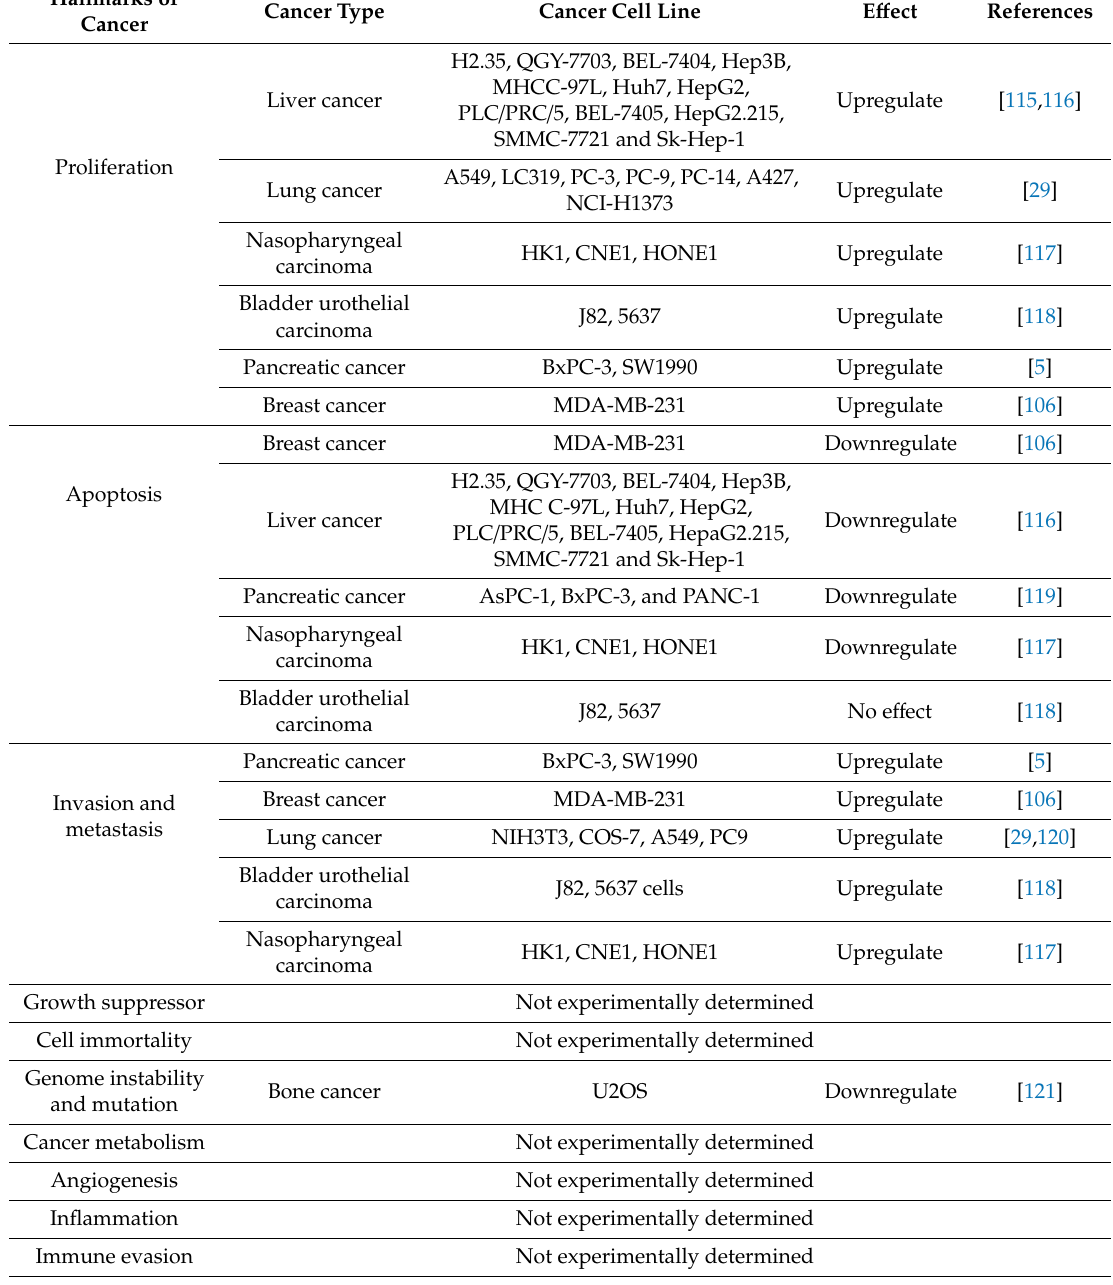
Table 2. The role of ANLN on the hallmarks in di ff erent cancer cell